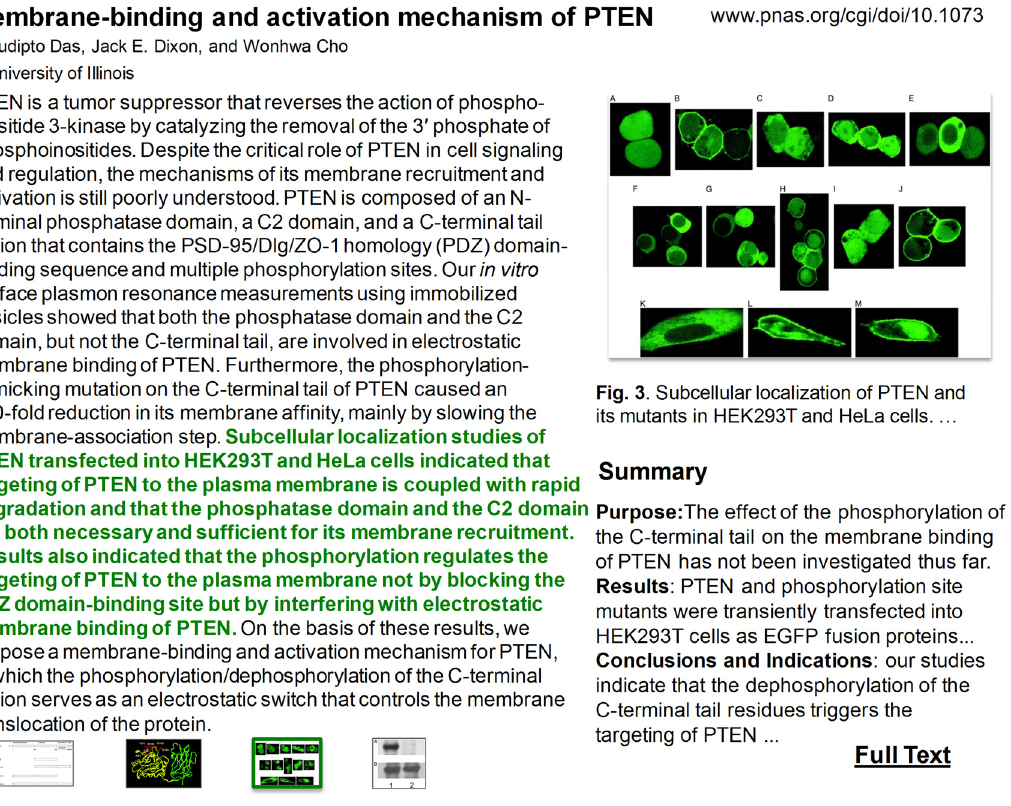
corresponding title based systems(0.283 and 0.255 for FIGlegend –